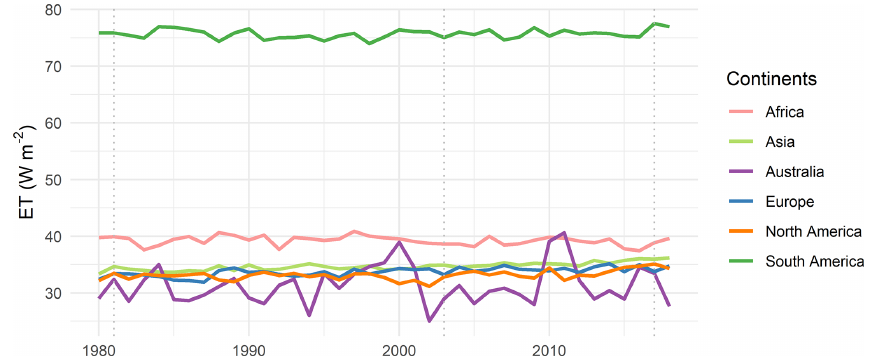
Figure 5. Annual average line plots of the area-weighted mean of continental ET exhibited by DOLCE V3. The vertical dashed lines mark the beginning of a new tier in 1981, 2003 and 2017.